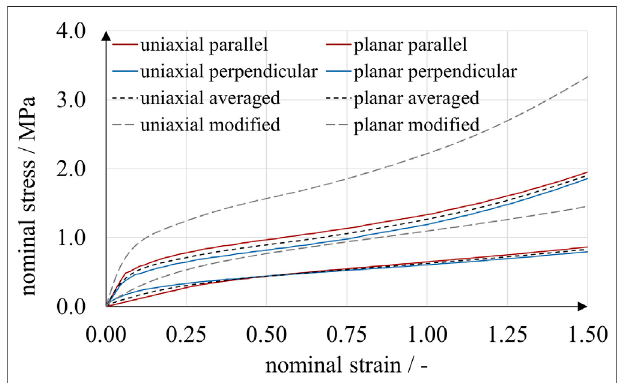
FIGURE 6 | Results of uniaxial and planar tensile experiments used for thecalibrationofhyperelasticmaterialmodels.Theresultswereobtainedfrom tensile experiments with parallelly and perpendicularly printed specimens at a loading rate of 10.0 mm/s and used for an initial approximation of the instantaneous material behavior. Data were subsequently modi fi ed in order to achieve accurate predictions in FE simulations.